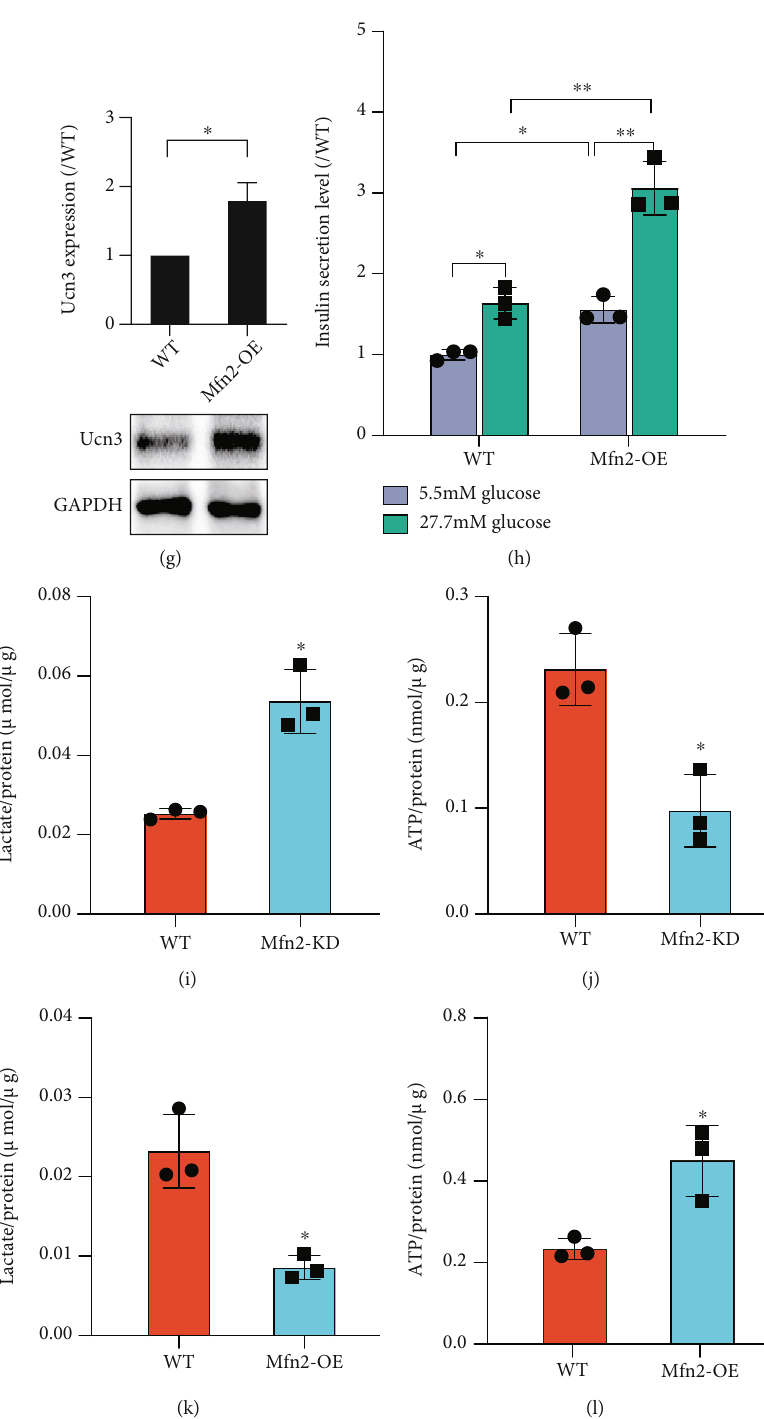
Figure 3: E ff ects of Mfn2 on β cell di ff erentiation and GSIS function on day 5 + 28 . (a) Mfn2 protein expression after Mfn2 knockdown by shRNA infection. (b) Ratio of insulin-positive cells after Mfn2 knockdown. (c) Ucn3 protein expression after Mfn2 knockdown. (d) Insulin secretion level of β cells after Mfn2 knockdown. (e) Mfn2 protein expression after Mfn2 overexpression. (f) Ratio of insulin-positive cells after Mfn2 overexpression. (g) Ucn3 protein expression after Mfn2 overexpression. (h) Insulin secretion level of β cells after Mfn2 overexpression. The insulin secretion level in each group was normalized to the insulin secretion level of WT cells stimulated